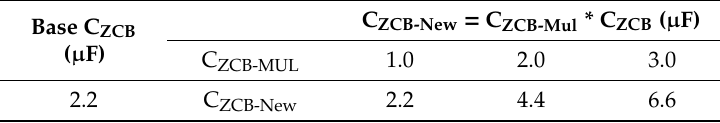
Table 2. Adjusted C ZCB values according to different C ZCB-Mul .